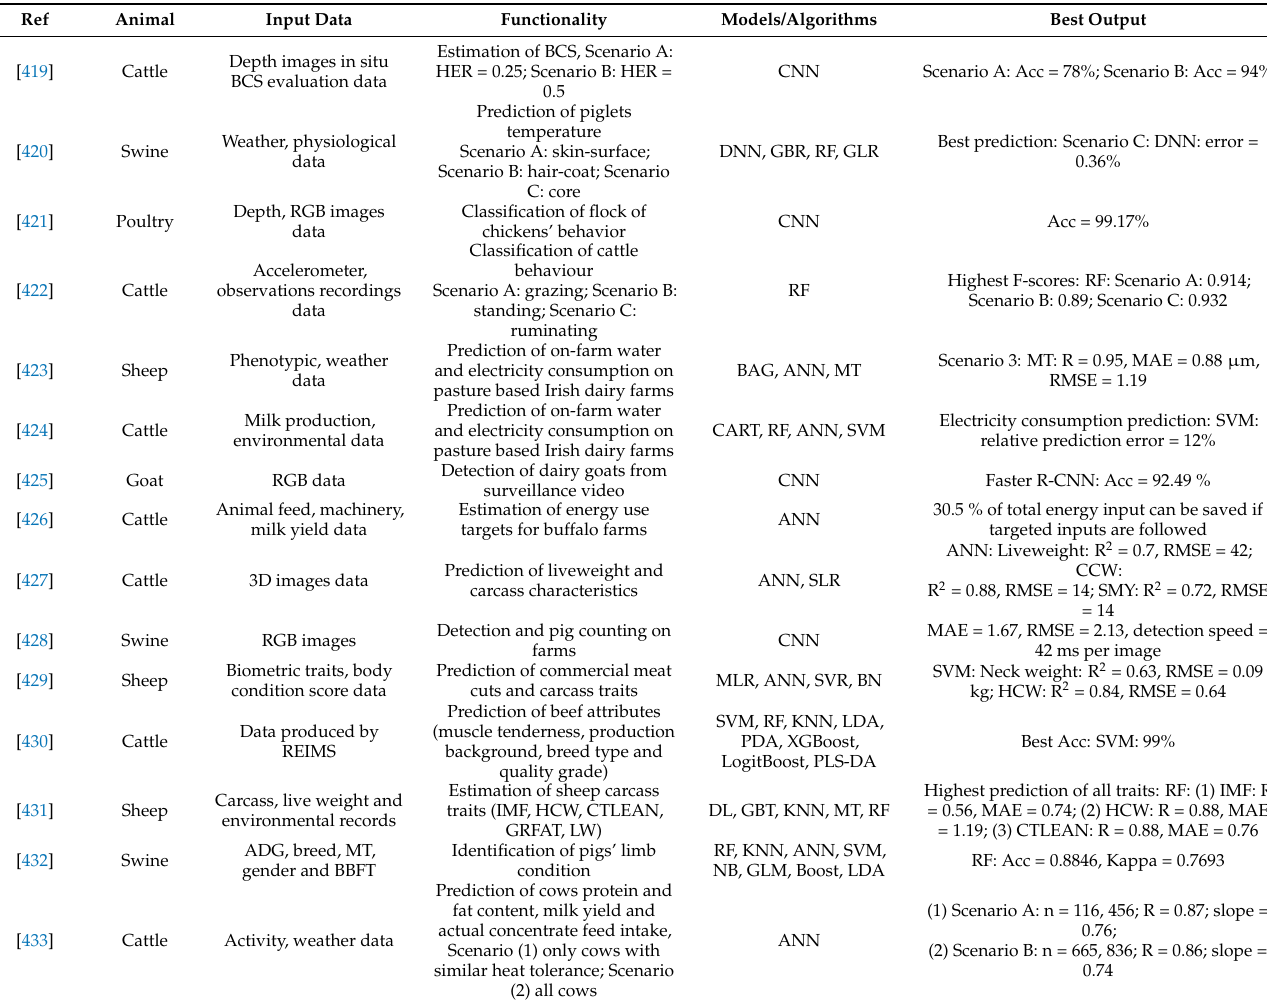
Table A9. Livestock Management: Livestock